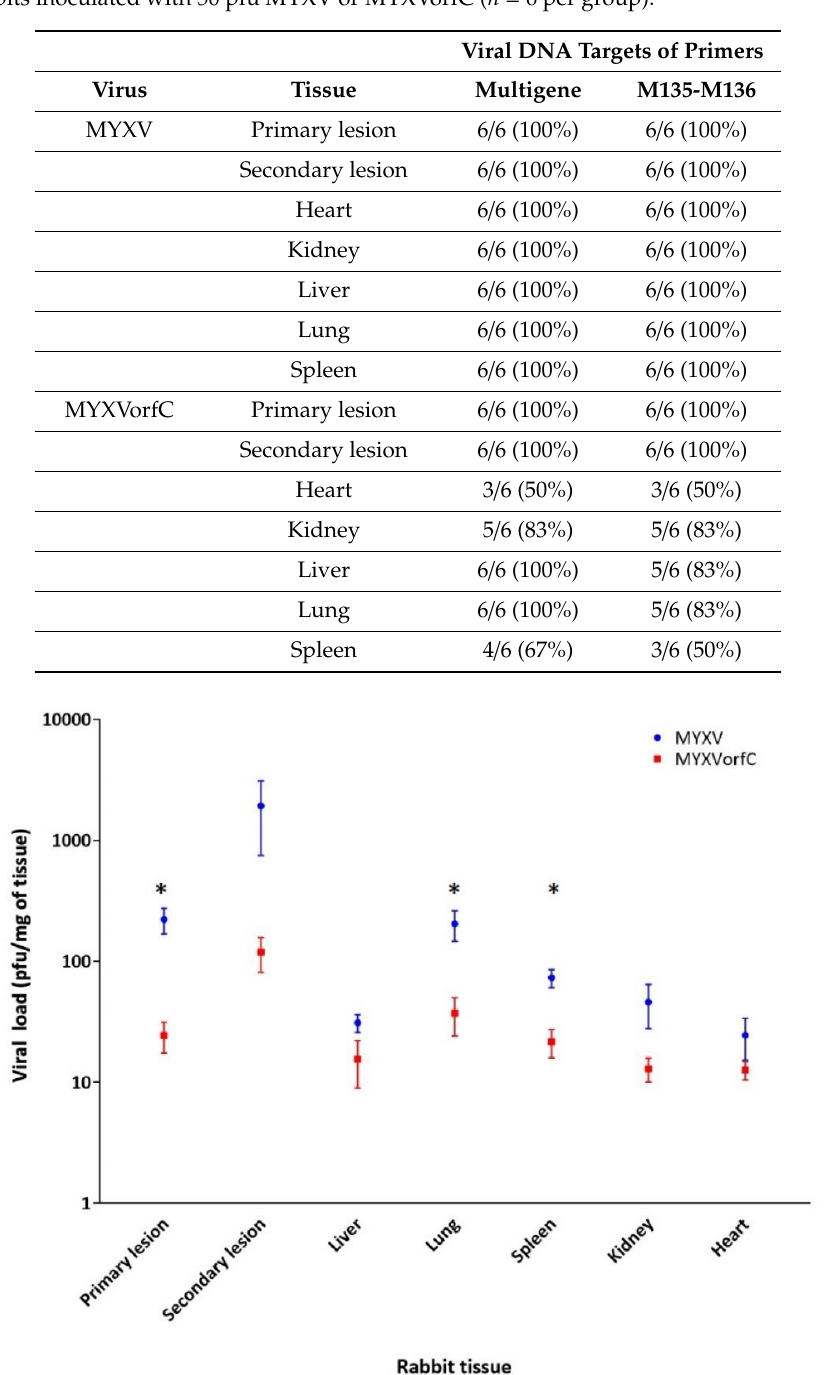
Figure 11. Average virus titer in rabbit tissues. Tissue homogenates from MYXV- and MYXVorfC-infected rabbits at the time of euthanasia contained replicating virus ( n = 6 per group). Significantly lower titers of MYXVorfC were extracted from primary lesions, lung, and spleen (error bars = SEM, * p -values <